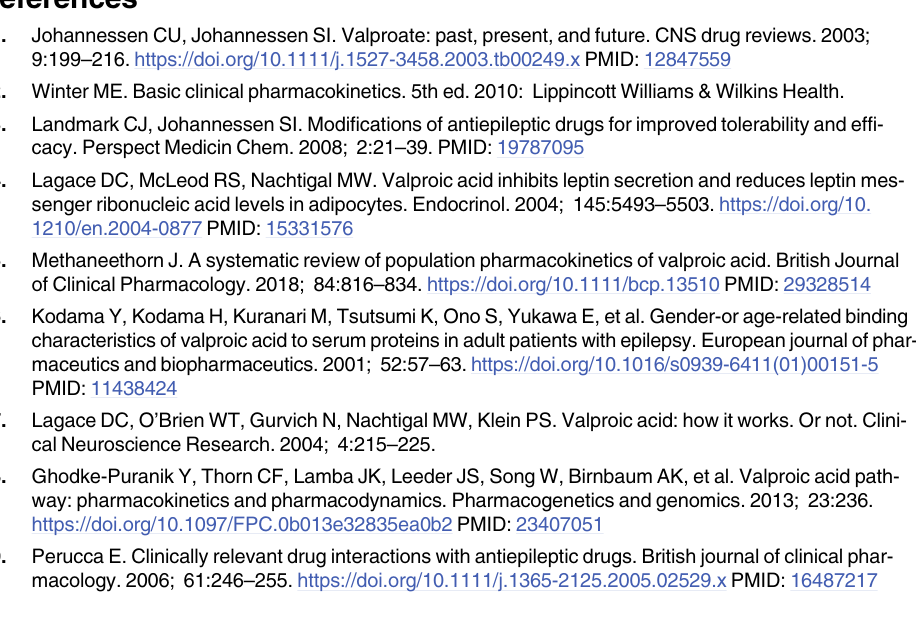
S1 Table. Results of stepwise covariate